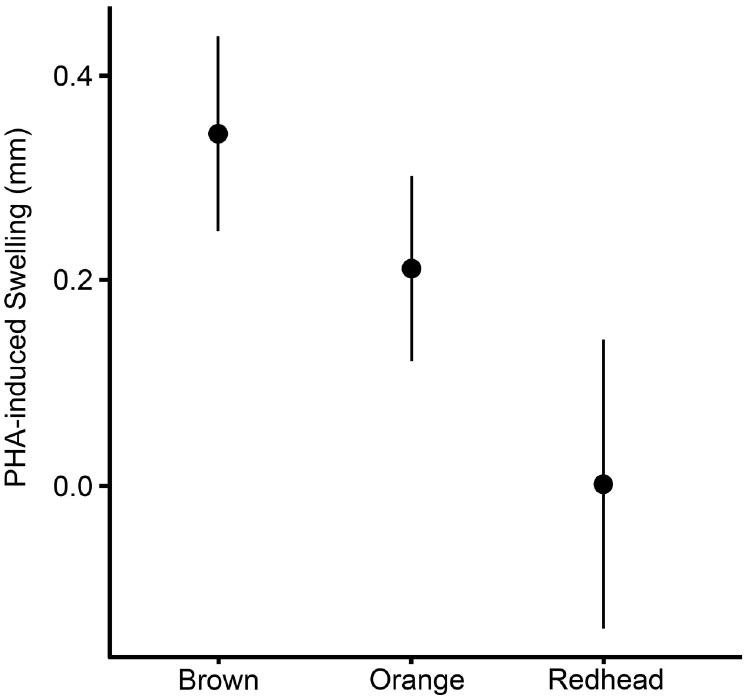
Fig 1. The immunocompetence of orange lizards (n = 12) did not differ significantly from that of brown (n = 25) or redhead lizards (n = 5). Brown lizards and redhead lizards differed significantly in immunocompetence. Error bars represent two standard errors from the mean (Means: Brown = 0.34, Orange = 0.24, Redhead = 0.0005). https://doi.org/10.1371/journal.pone.0209261.g001 (Table 4). They were equally inconpicuous to their conspecifics (Tables 4 and 5). The red heads of redhead lizards were rarely easily discriminable by UV-sensitive birds and conspecif- ics. They were never easily discriminable by violet-sensitive birds, regardless of background or light environment (Table 4). Dewlaps were always more often easily discriminable than orange, brown, or redhead patches, regardless of viewer, background, or light environment (Table 4). Table 2. Fitness measures assessed in this study and their relationships to individual attributes. PHA